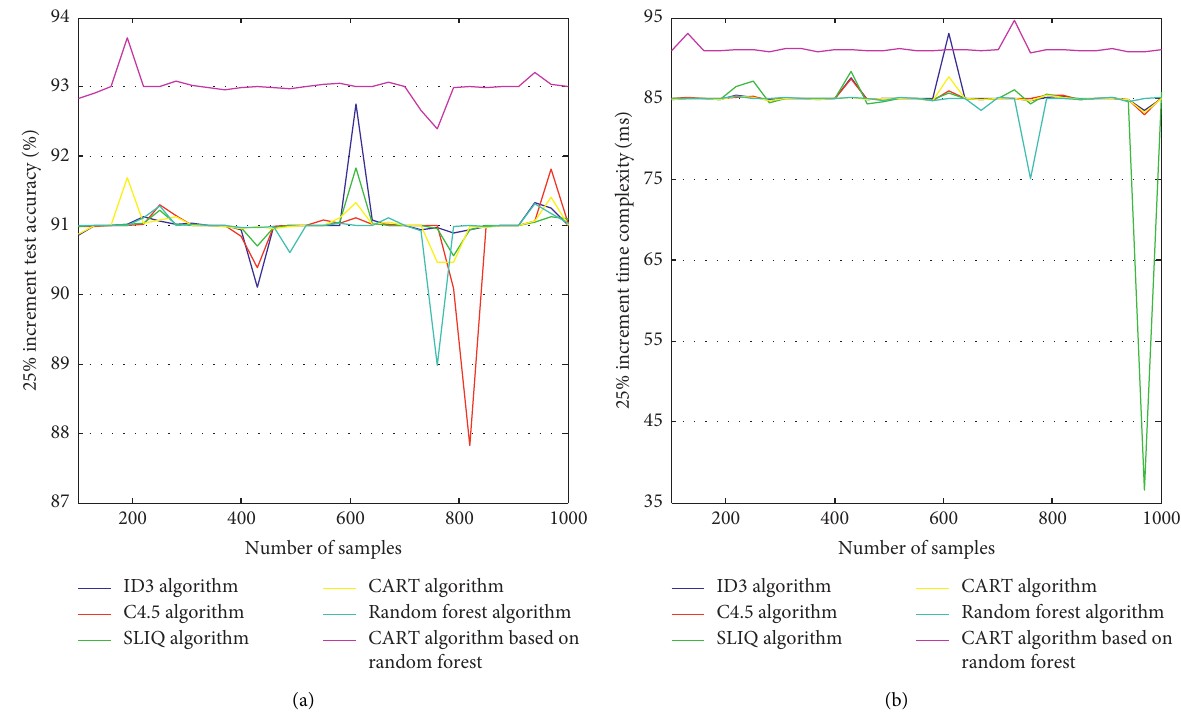
Figure 4: Comparison of two algorithm tests with an increment of 25%. (a) Incremental 25% two algorithm test accuracy comparison chart. (b) Incremental 25% two algorithm time complexity comparison chart.